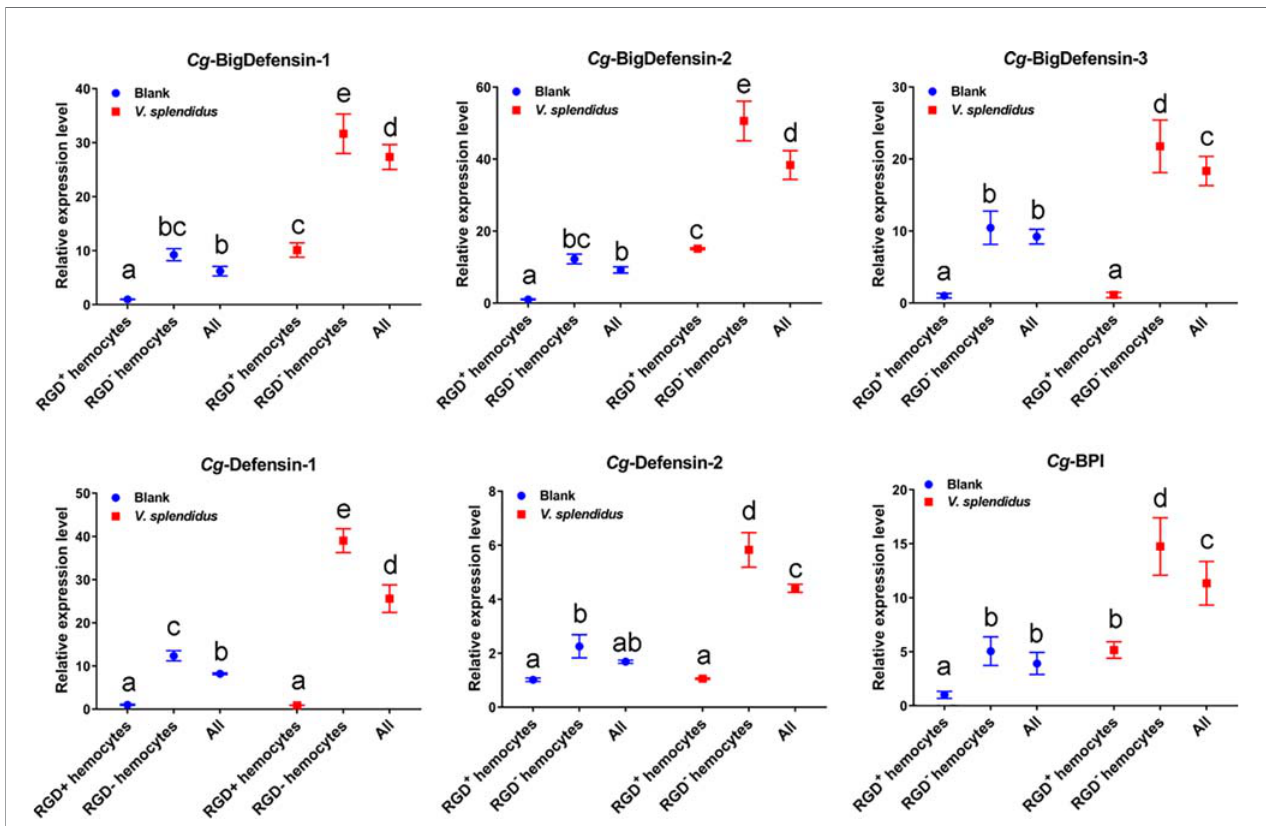
FIGURE 9 | Changes in the mRNA expression of representative AMPs in different hemocyte populations before and after V. splendidus challenge. The relative expression levels of the reported AMPs, including Cg -BigDefensin-1, Cg -BigDefensin-2, Cg -BigDefensin-3, Cg -Defensin-1, Cg -Defensin-2, and Cg -BPI, in all hemocytes, RGD + hemocytes, and RGD - hemocytes were detected by qPCR. The letters “ a, b, c, etc. ” indicate statistical signi fi cance at p <